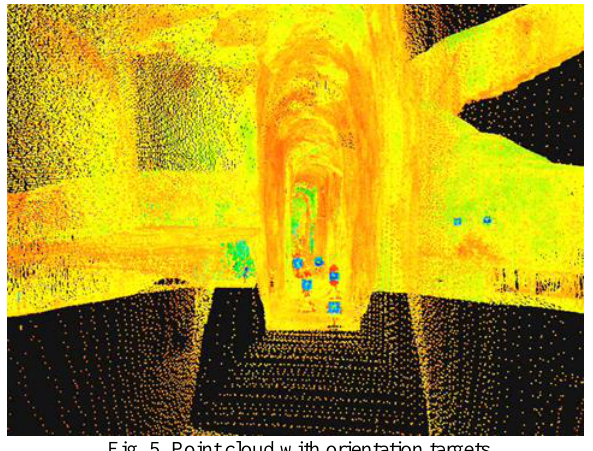
Fig. 5. Point cloud with orientation targets